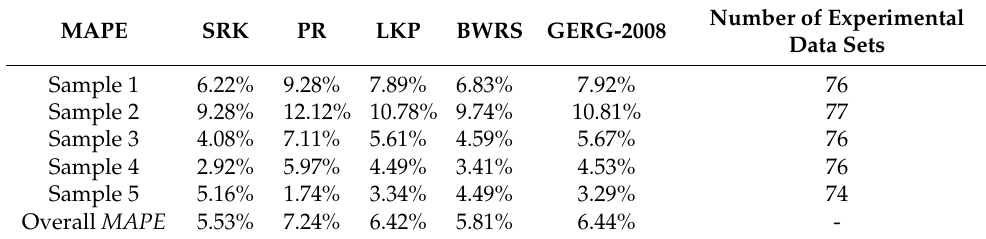
Table 9. MAPE s of experimental and calculated results in the volumetric coefficient prediction.